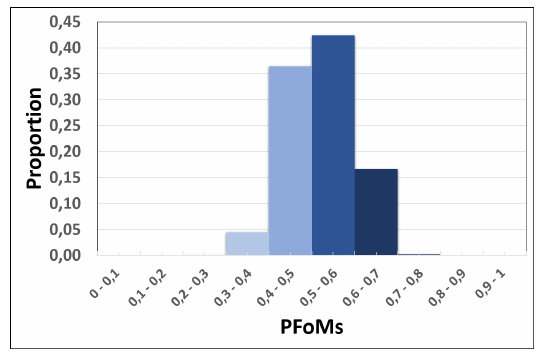
Figure 3. Histogram of proportions of PFoMs obtained with the Figure 5. Histogram of proportions of PFoMs obtained with the Adaptive Canny Method for Medium objects, from 7 to 12 Adaptive Canny Method for Very Large objects, from 22 to 40 pixels, both included pixels, both included